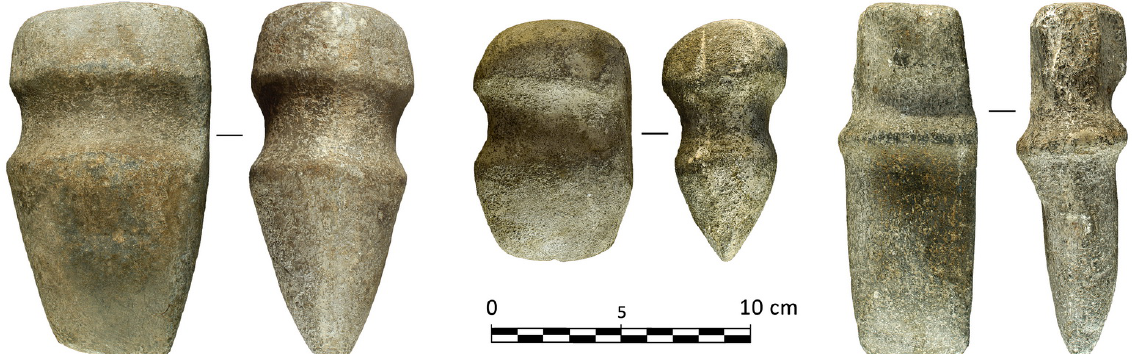
Figure 2. Grooved hammer-axes kept in the Museo Archeologico Provinciale in Catanzaro: A. from Palermiti (Catanzaro), ID 1003; B. from Zagarise (Catanzaro), ID 1005; C. from Cortale (Catanzaro), ID